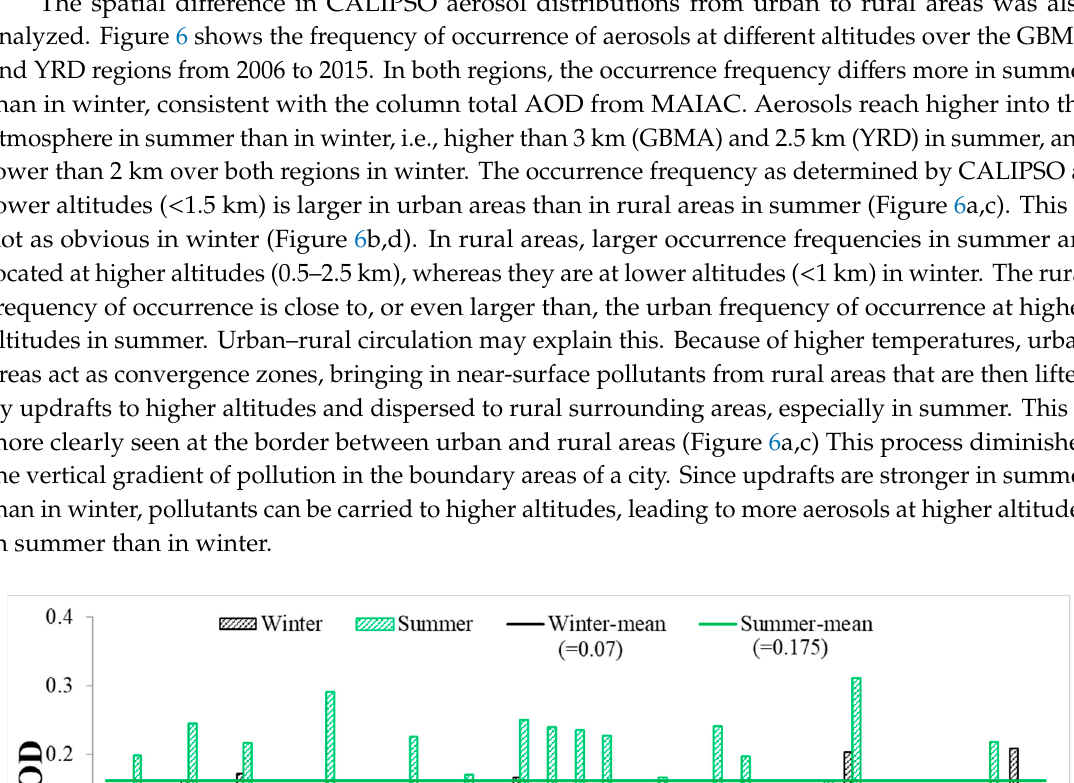
Figure 5. Mean AOD as a function of distance from the urban geometrical center of each city in winter (black curves with open circles) and summer (green curves with crosses). Note that wintertime AOD data are not available at cities Harbin and Changchun. The distance ranges are <10 km, 11–20 km, 21– 31 km, 31–40 km, and 41–50 km from the urban geometrical center.